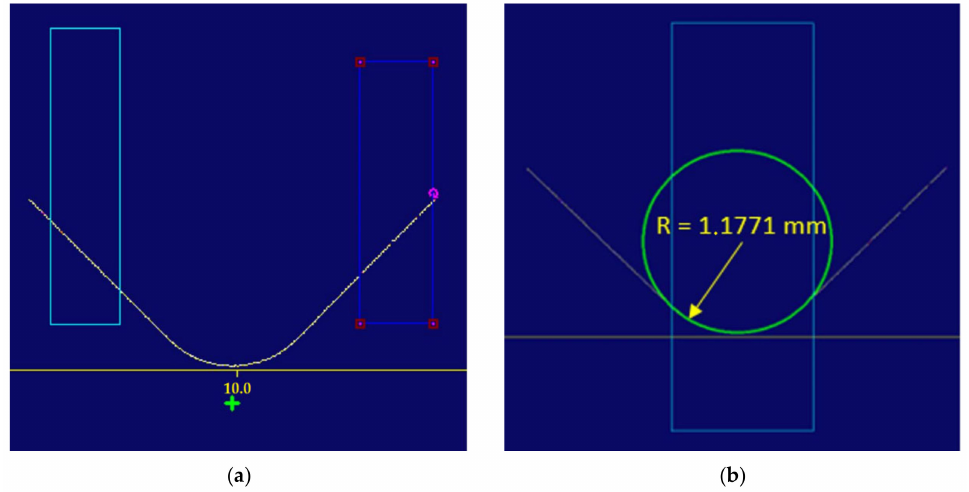
Figure 14. ( a ) Determination of the intersection point of the straight lines produced by approximation; ( b ) The measurement area rectangle and the determined radius.